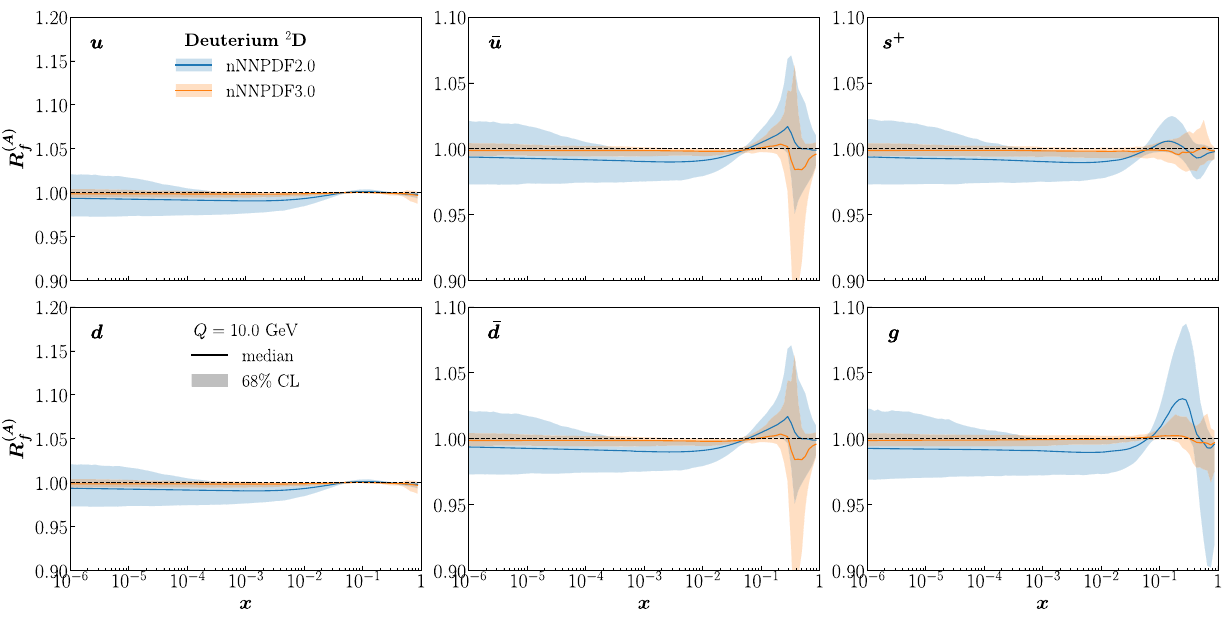
( x , Q ) at Q = 10 GeV for A = 208 (lead), A = 108 (silver) and A = 31 (the mean atomic mass Fig. 15 The nuclear modification factors R ( A ) f number of nuclei typically encountered by ultra-high-energy neutrinos propagating through the Earth)